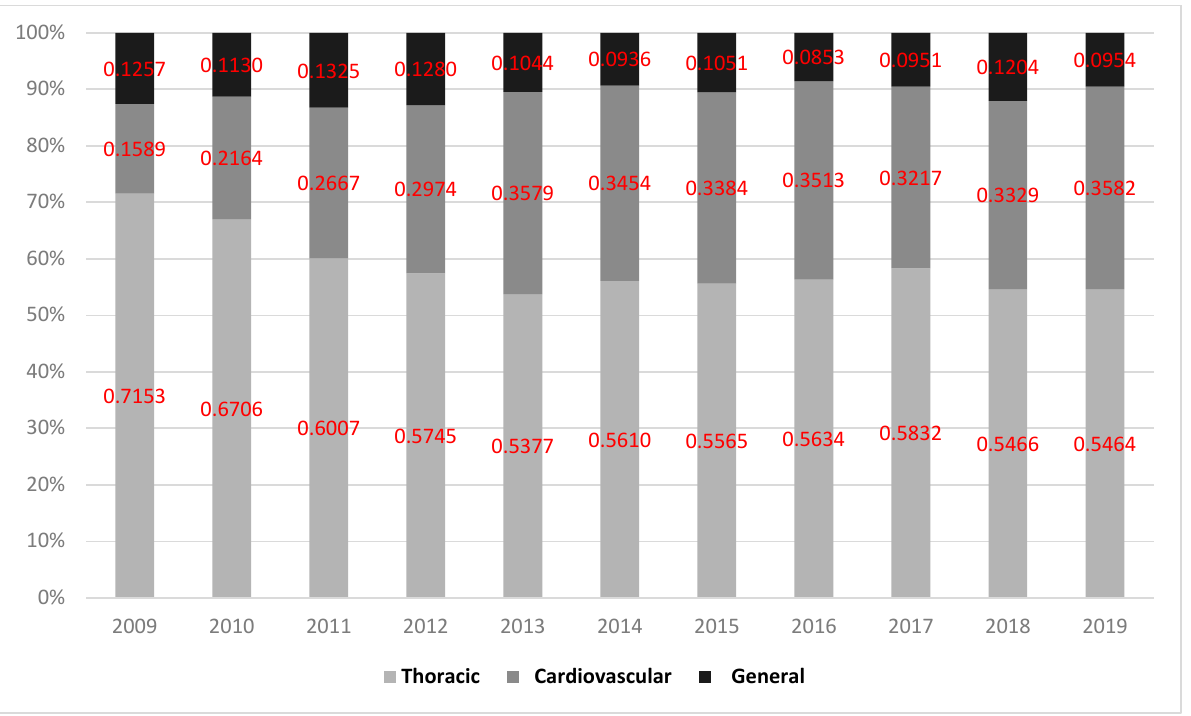
Figure 2. Distribution of lung lobectomies performed by each provider type in the Premier Healthcare Database from 2009 to 2019.